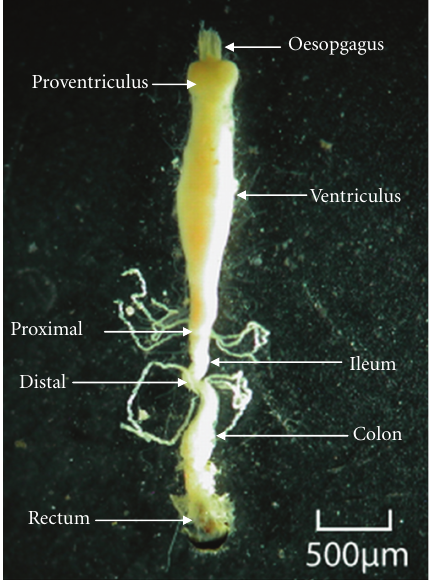
Figure 3: Photomicrograph of the resected thoracic and abdominal sections of the alimentary tract of C. septempunctata , with proximal and distal ends of the malpighian tubules attached.